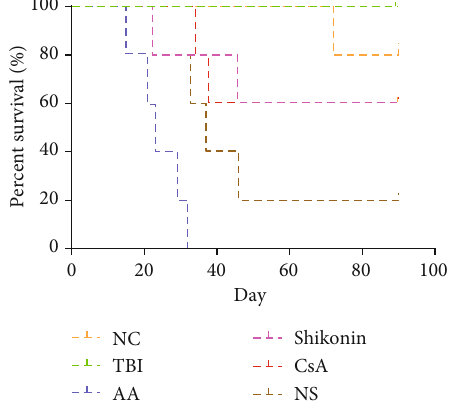
Figure 6: The survival rates of the mice from the NC ( n = 10 ), TBI ( n = 10 ), AA model ( n = 5 ), shikonin ( n = 5 ), CsA ( n = 5 ), and NS ( n = 5 ) groups were examined and compared for 90 days or until death. The mice from the Shikonin and CsA groups had a higher survival rate than the AA model and NS groups ( p < 0 : 05 ). No signi fi cant di ff erence was observed between the TBI and NC groups. AA: aplastic anemia; TBI: total body irradiation; NC: normal control; CsA: cyclosporin A; NS: normal